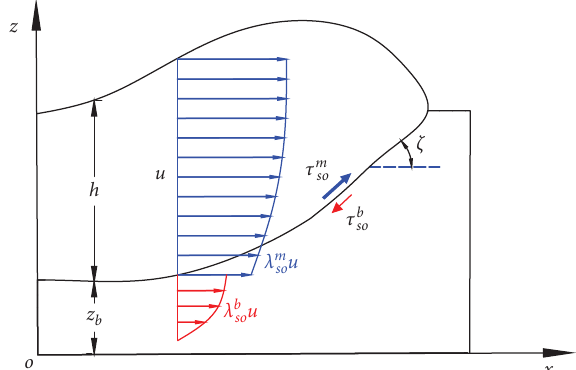
Figure 2: Schematic diagram of erosion-entrainment model based on the mechanical principles presented by Pudasaini and Fischer [23] and Pudasaini and Krautblatter [26]. Te fow depth of the landslide is h , the vertical coordinate of the top of the bed is z b , the average velocity of the landslide mass is u , while λ m so and λ b so are the erosion drift coefcients that relates the velocity at the bottom of the landslide and the velocity at the top of the bed to the average fow velocity. Shear stress generated by the mixture of the solid and obstacle phase on the bed is denoted as τ m so , and conversely, the shear stress produced by the bed on these two phases is τ b so